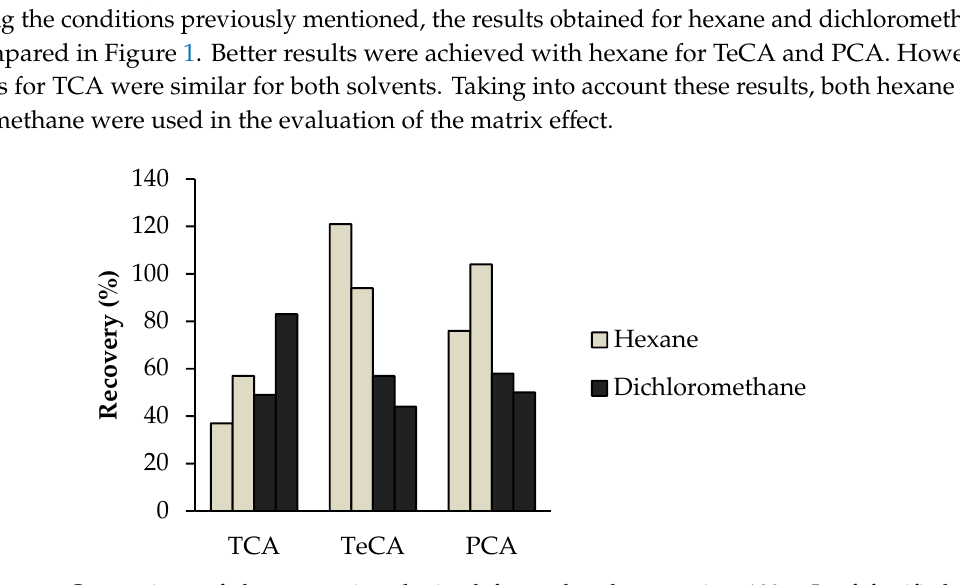
Figure 1. Comparison of the recoveries obtained for each solvent, using 100 mL of fortified hydroalcoholic solution, 6 min drying time and 20 mL min − 1 flow rate ( n =